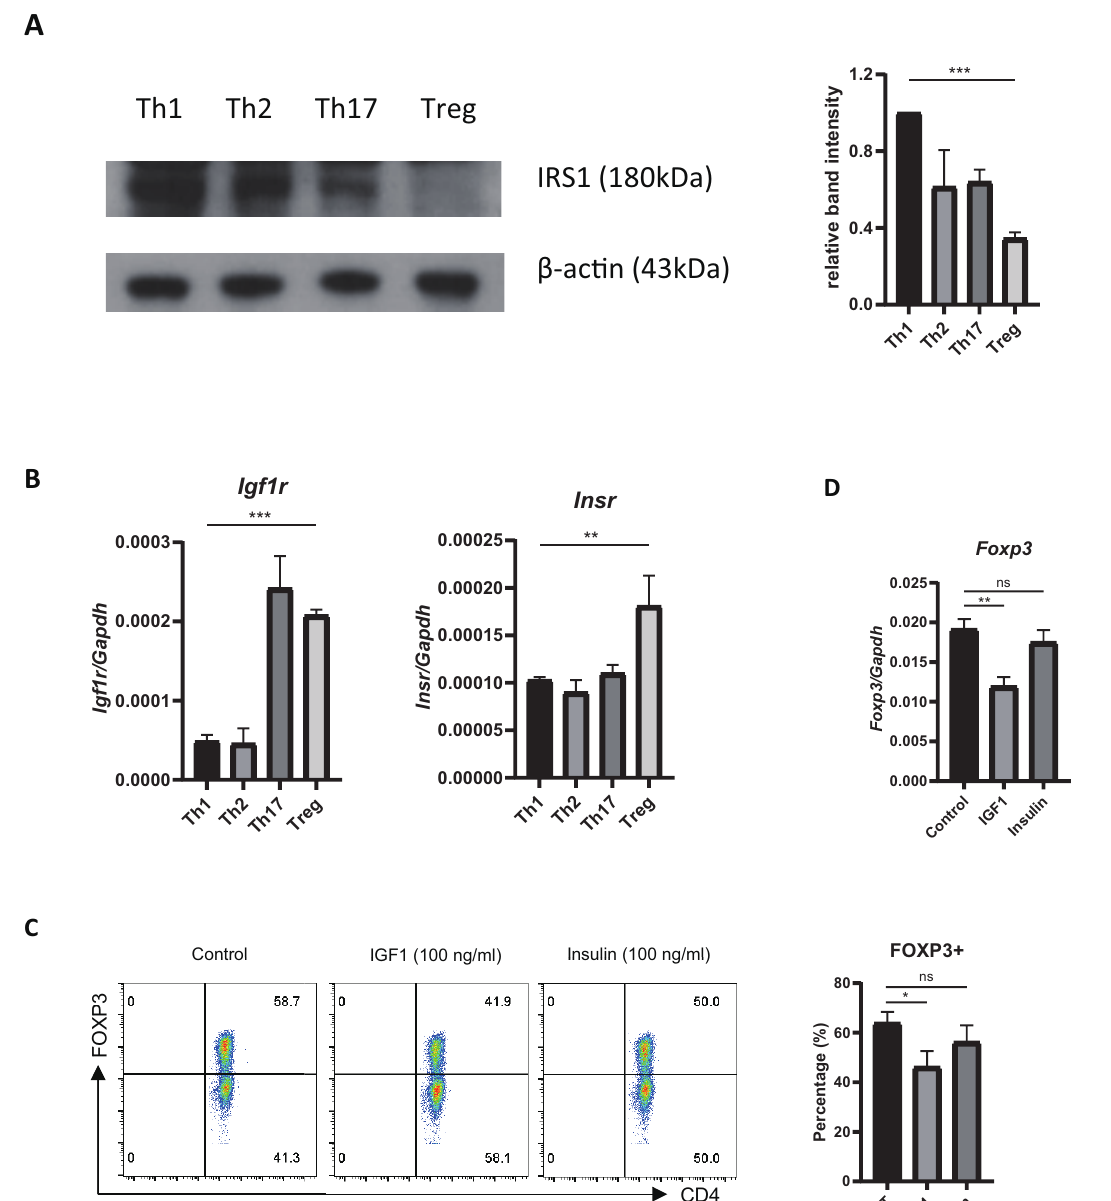
Figure 1. Expression of IRS and IRS-mediated signaling in Treg cells. ( A ) IRS1 was measured in Th1, 2, 17, and Treg cells via immunoblotting. Data were normalized to expression of β -actin. Data were pooled from three independent experiments. ( B ) Naïve CD4 T cells were cultured under Treg- inducing conditions for 3 days, and expression of Igf1r and Insr mRNA was measured via qRT-PCR. ( C ) Naïve CD4 T cells were cultured under Treg-inducing conditions for 3 days with PBS (control), IGF1, or insulin. FOXP3 protein levels were measured via flow cytometry, and ( D ) Foxp3 mRNA level was measured via qRT-PCR. Data are representative of three independent experiments. The bar graph next to the flow cytometry data shows data pooled from three independent experiments. The error bars represent the SD, ( A – D ) p -values were calculated using one-way ANOVA/Tukey test. * p < 0.05, ** p < 0.01, *** p < 0.001. ns: not